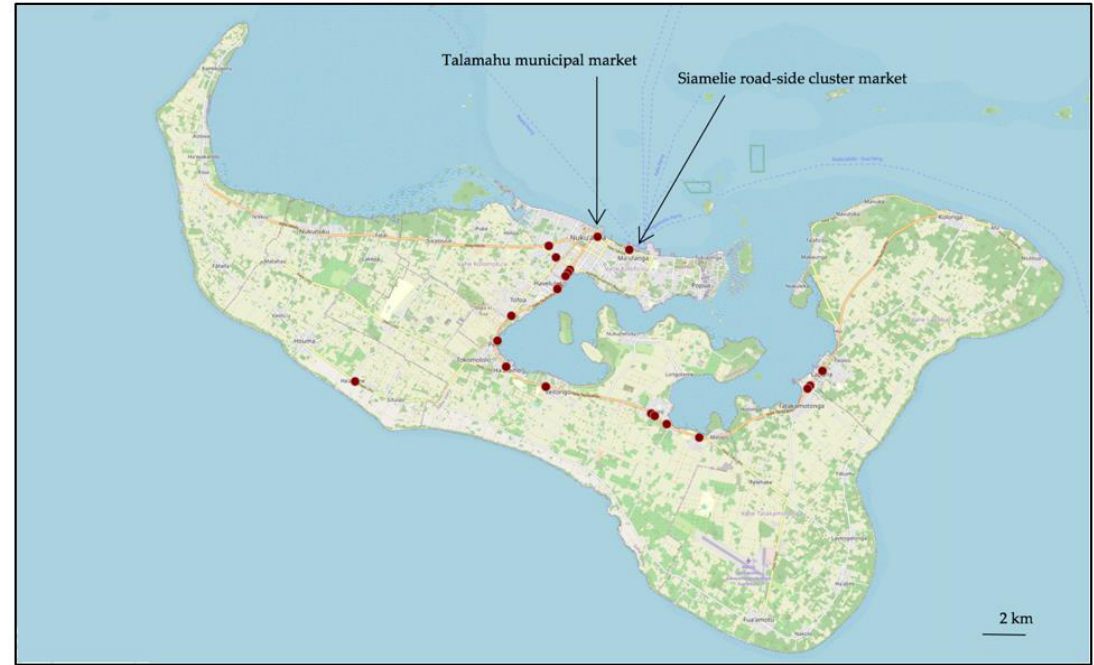
Figure 6. The spatial distribution of market vendors on Tongatapu Island who reported postharvest loss. Map source: Open street map 2019 and KoBoToolBox™ with survey result overlays.